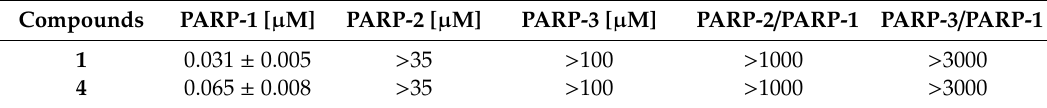
Table 4. Selectivity of compounds 1 and 4 to